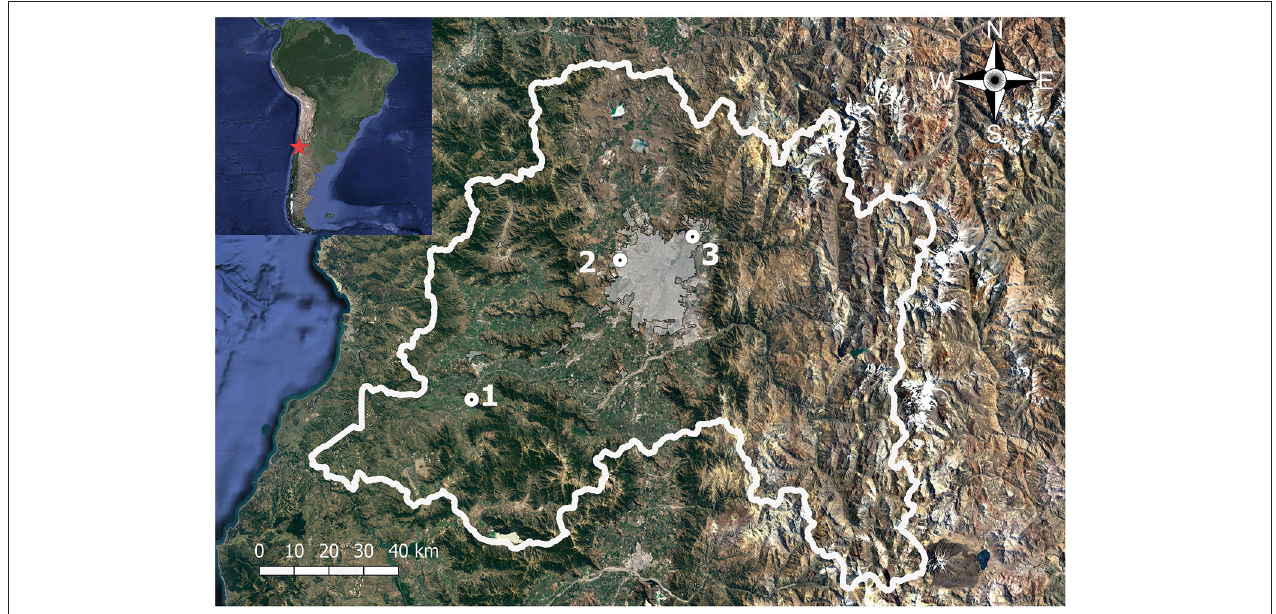
FIGURE 1 | Geographical representation of the Santiago Metropolitan Region (area marked with a white line) and the monitoring sites. (1): Rural; (2): Urban; (3): Urban receptor.